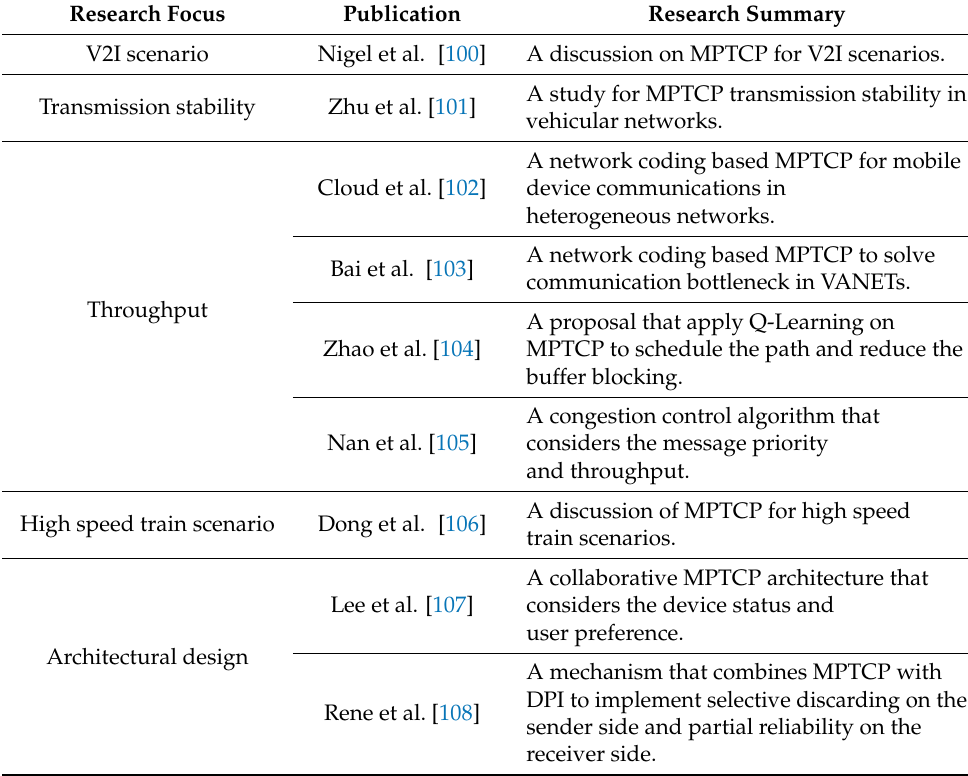
Table 4. Studies on MPTCP in a vehicular ad hoc